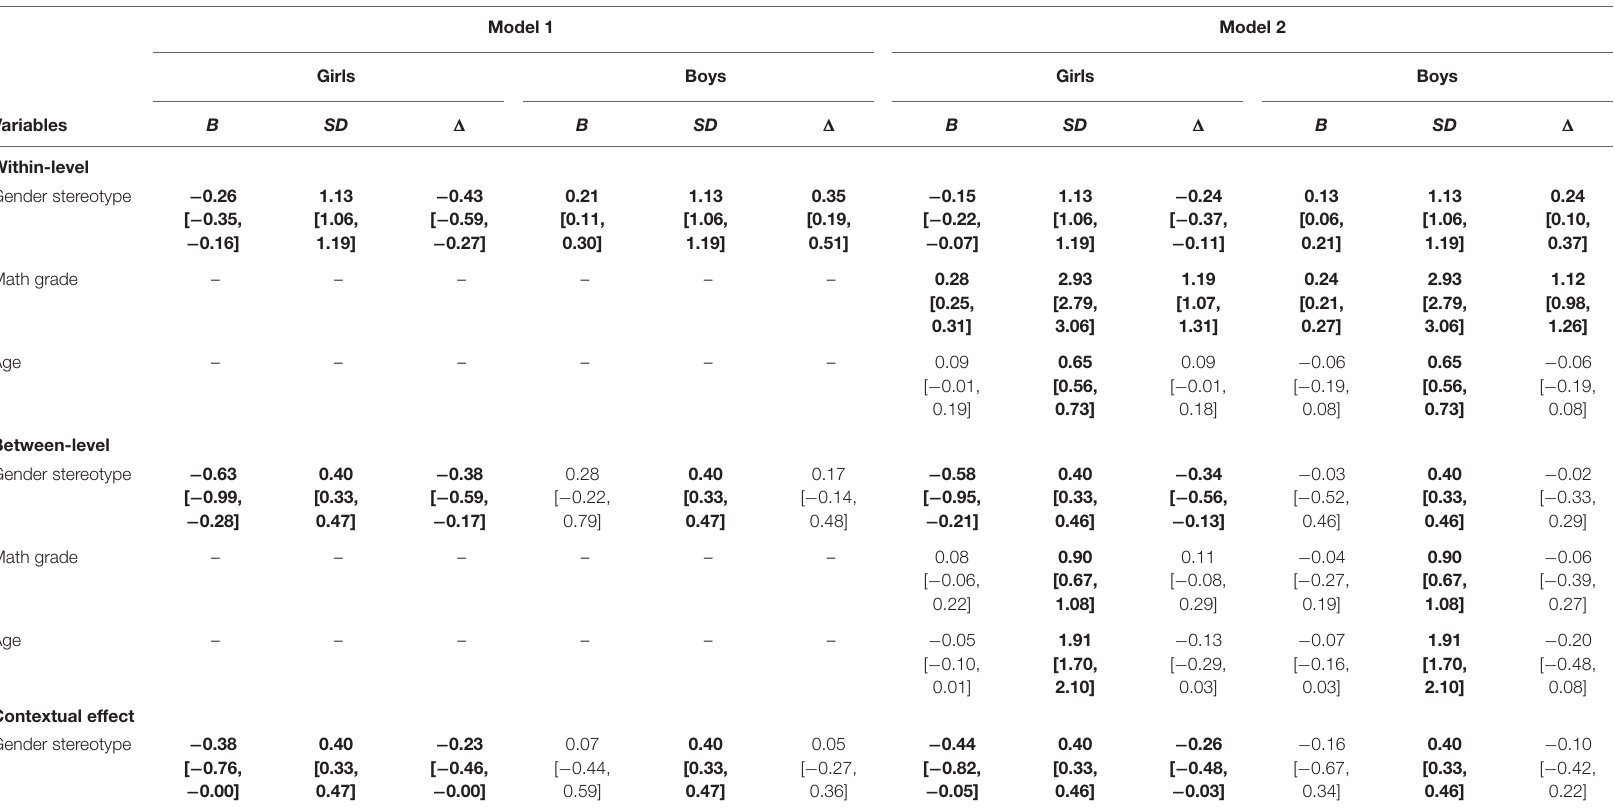
TABLE 3 | Unstandardized regression coefficients, standard deviations, and Tymms’ (cid:49) [with 95% confidence intervals] of the multilevel analyses predicting students’ math self-concept. Model 1 Model 2 Girls Boys Girls